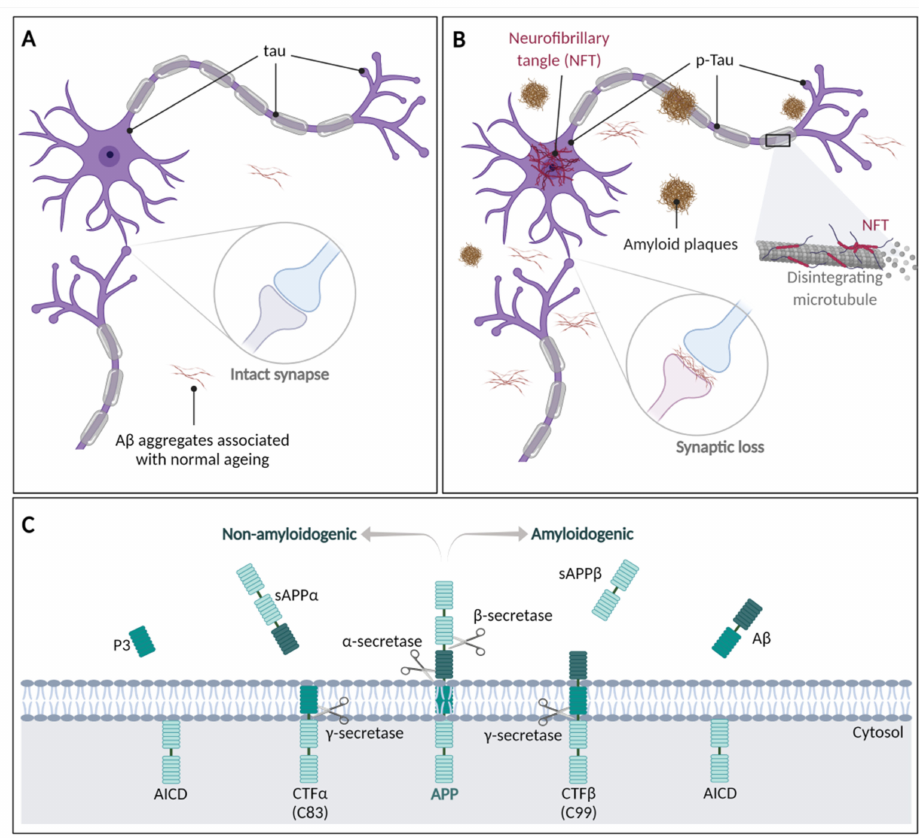
Figure 6. The molecular basis of Alzheimer’s disease . ( A ) Healthy cognitive ageing. ( B ) Alzheimer’s disease pathology. ( C ) Human APP proteolytic pathways. Adapted from Müller et al. [226], De Strooper et al. [239], Chen et al. [240]. Created with